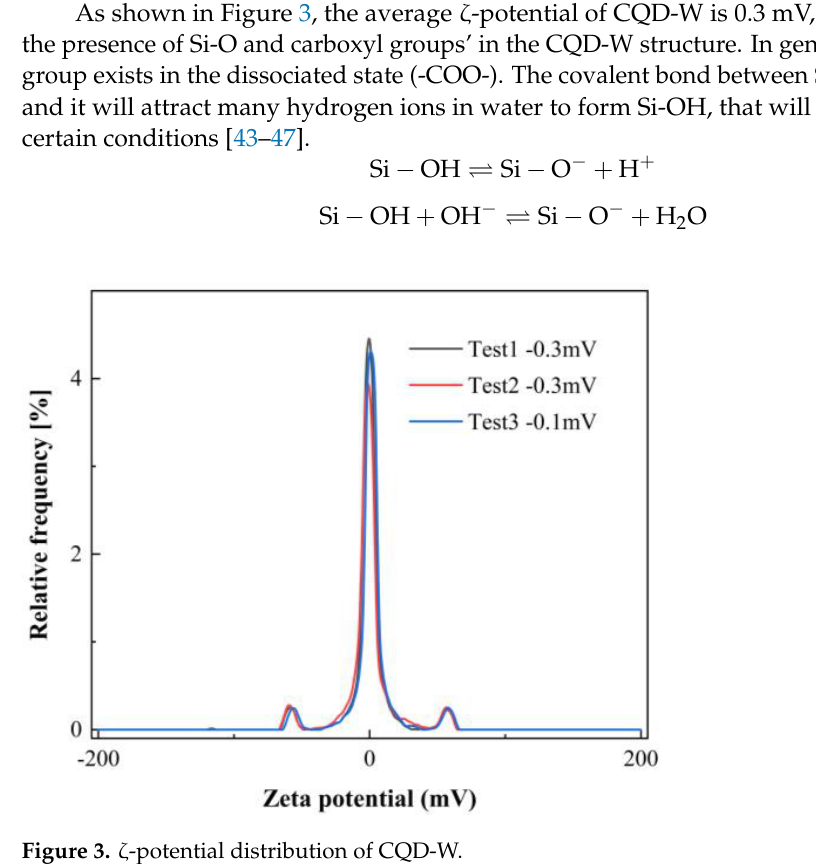
Figure 2. Fourier Transform Infrared (FTIR) Spectroscopy of CQD-W.